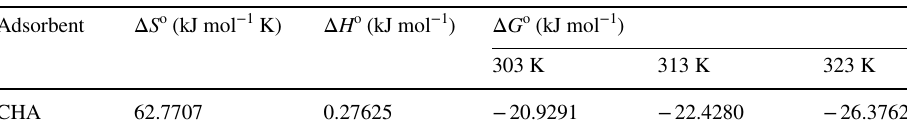
Table 8 Thermodynamic parameters for adsorption onto CHA